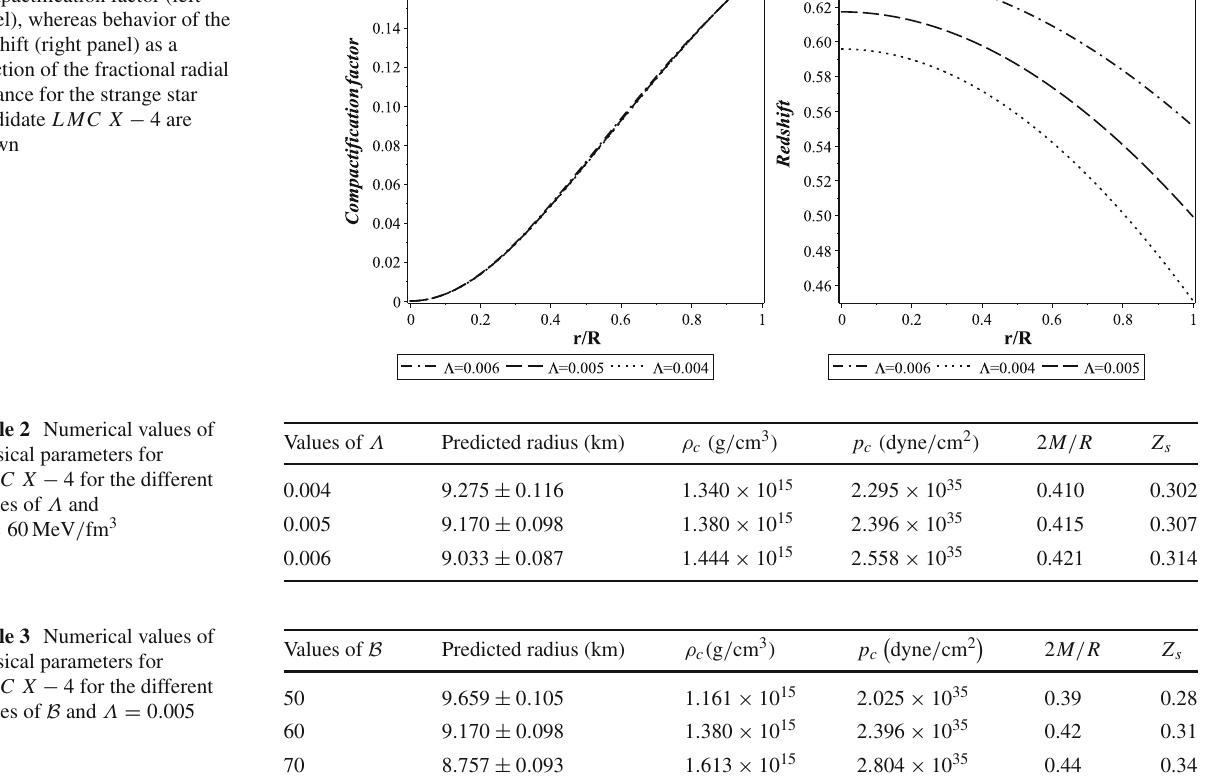
Fig. 10 Behavior of the compactification factor (left panel), whereas behavior of the redshift (right panel) as a function of the fractional radial distance for the strange star candidate LMC X − 4 are shown